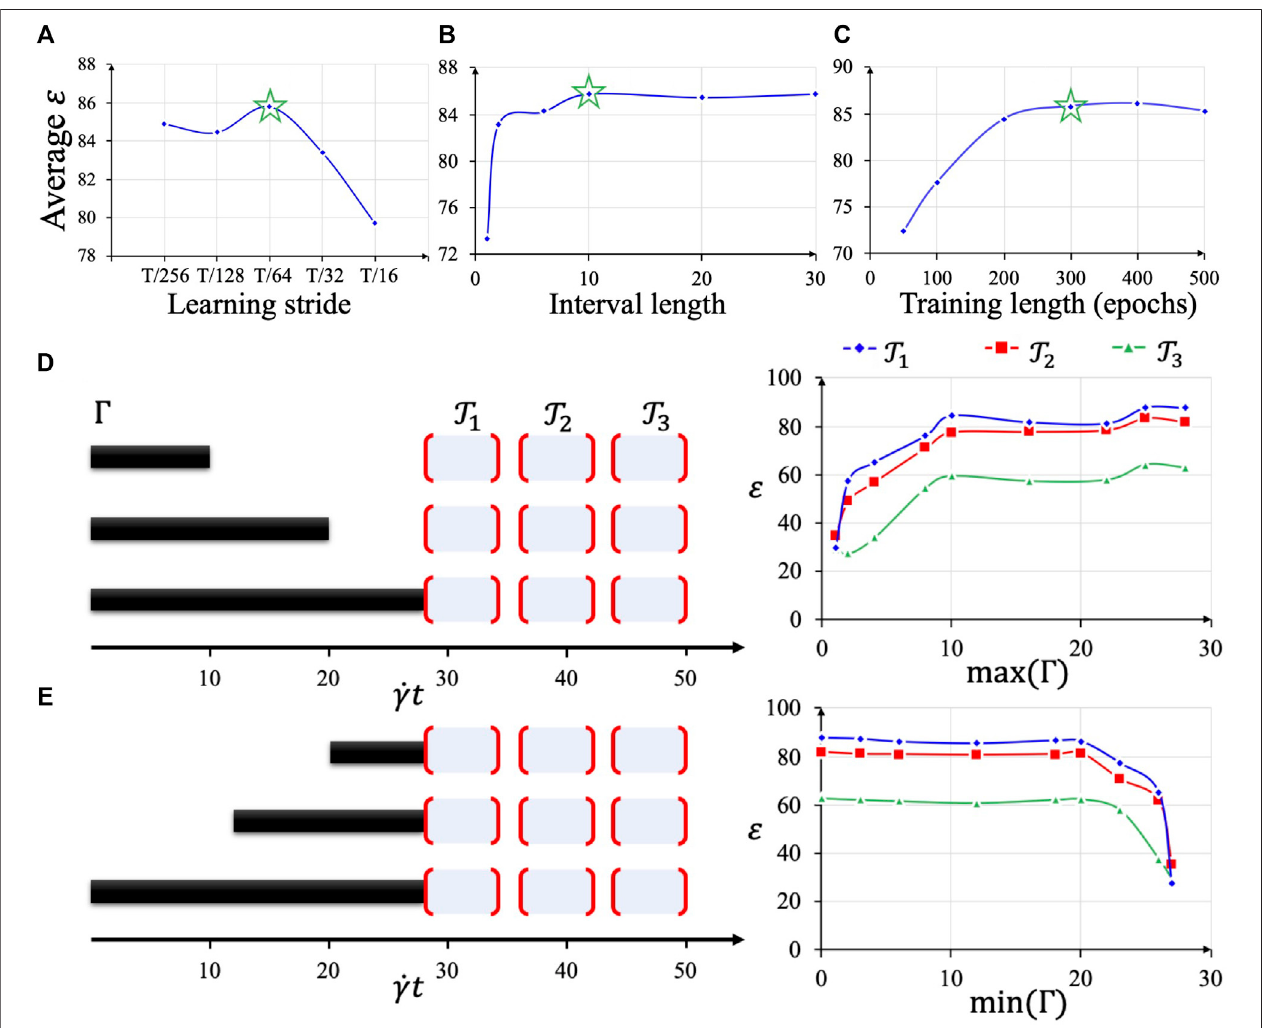
FIGURE6| Hyperparameterselectionbasedonaveragetestaccuracy (A – C) .Usingtheoptimalhyperparametercombination,differentlengthsofsequences Γ (D, E) arefedasonlinetraininginputs,thenevaluatedbythreedifferentfuturetests T 1 , T 2 , T 3 .Theonlinepredicteddynamicalfeaturesaretemporal sensitive.Deformable platelet at 100 dyne/cm 2 is used as the presenting